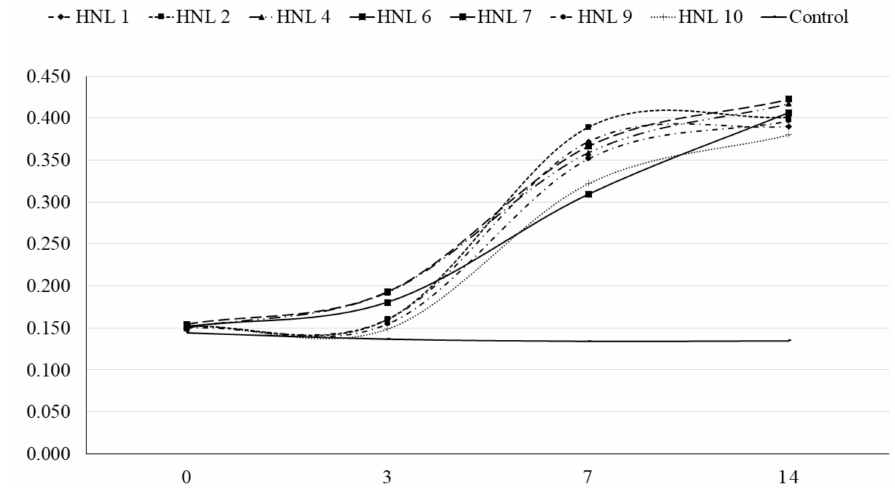
Figure 3. Optical density (630 nm) of T. phagedenis isolates OTEB culture from 0 to 14 days of incubation at 37 ◦